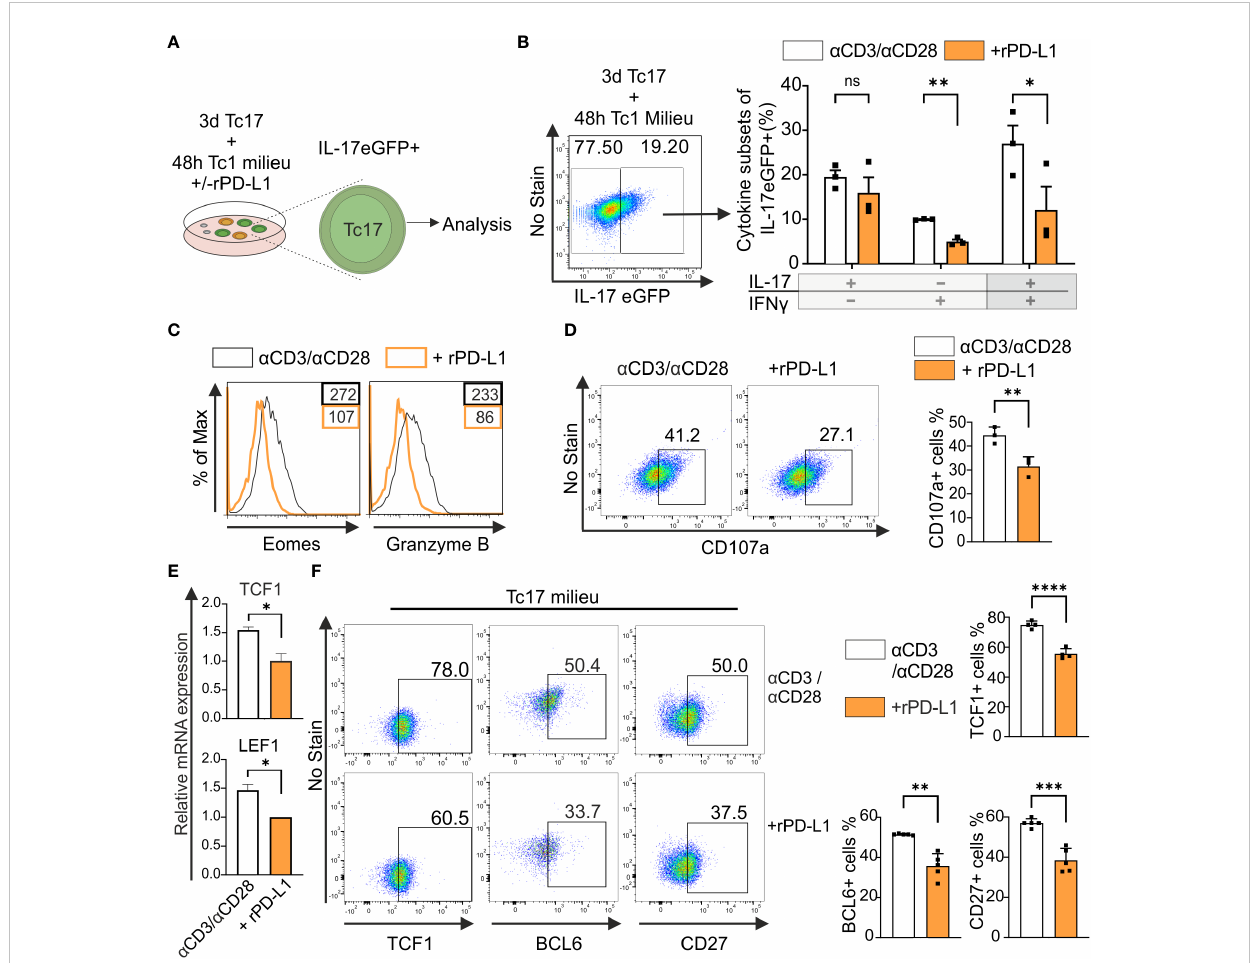
FIGURE 5 PD-1 suppresses cytotoxic potential and stemness of Tc17 cells. (A, B) CD8 + T-cells from IL-17A-eGFP reporter mice were stimulated with microspheres immobilized with anti-CD3, anti-CD28 for 3 days under Tc17 conditions. These cells were then restimulated with fresh microspheres immobilized with anti-CD3, anti-CD28, and rPD-L1 or IgG under Tc1 conditions for 48h and thereafter Tc17 cell plasticity (A) was determined by measuring IL-17 and IFN- g expression (B) by fl ow cytometry within IL-17 eGFP expressing previous IL-17 producers. The (A) was partly generated using Servier Medical Art, provided by Servier, licensed under a Creative Commons Attribution 3.0 unported license. (C) CD8 + T-cells were stimulated as in (A) and, Eomes and granzyme B expression was measured by fl ow cytometry. (D) CD8 + T-cells from C57BL/6 mice were stimulated as in (A) and analyzed for the expression of degranulation-associated surface molecule CD107a. (E) CD8 + T-cells from C57BL/6 mice were stimulated with microspheres immobilized with anti-CD3, anti-CD28 and rPD-L1 (+rPD-L1) or IgG ( a CD3/ a CD28) antibodies under Tc17 condition and harvested 24h after activation. The harvested cells were lysed, RNA was extracted, and RT was used to synthesize cDNA. The relative expression levels of TCF1 and LEF1 genes analyzed using real-time PCR are shown as mean+SD of replicates from an experiment. (F) Tc17 cells were stimulated as in (E) and expression of TCF1, BCL6 and CD27 were measured by fl ow cytometry at day 3. The data is representative of two to fi ve independent experiments. Data points represent individual experiments with mean+SD. ****P < 0.0001, *** P <0.001, ** P <0.01, * P <0.05; ns, not signi fi cant, calculated by Welch ’ s t-